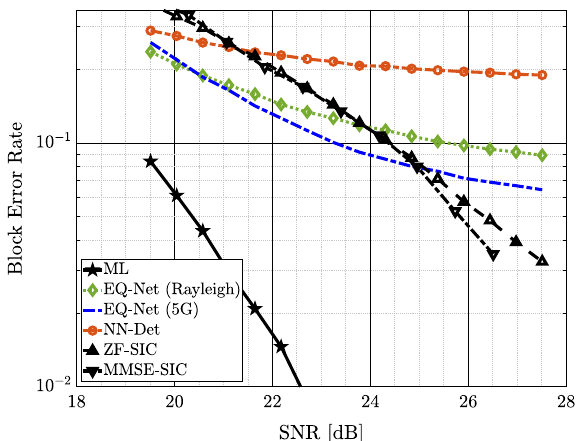
Fig. 12 Estimation performance of EQ-Net (L), and the similarly performing NN-Det (P) under a severe distributional shift induced by training on an i.i.d. Rayleigh fading channel, and testing on the 5G-NR CDL-A MIMO channel model for 2 × 2 , 64-QAM, and LDPC-coded with size (324,